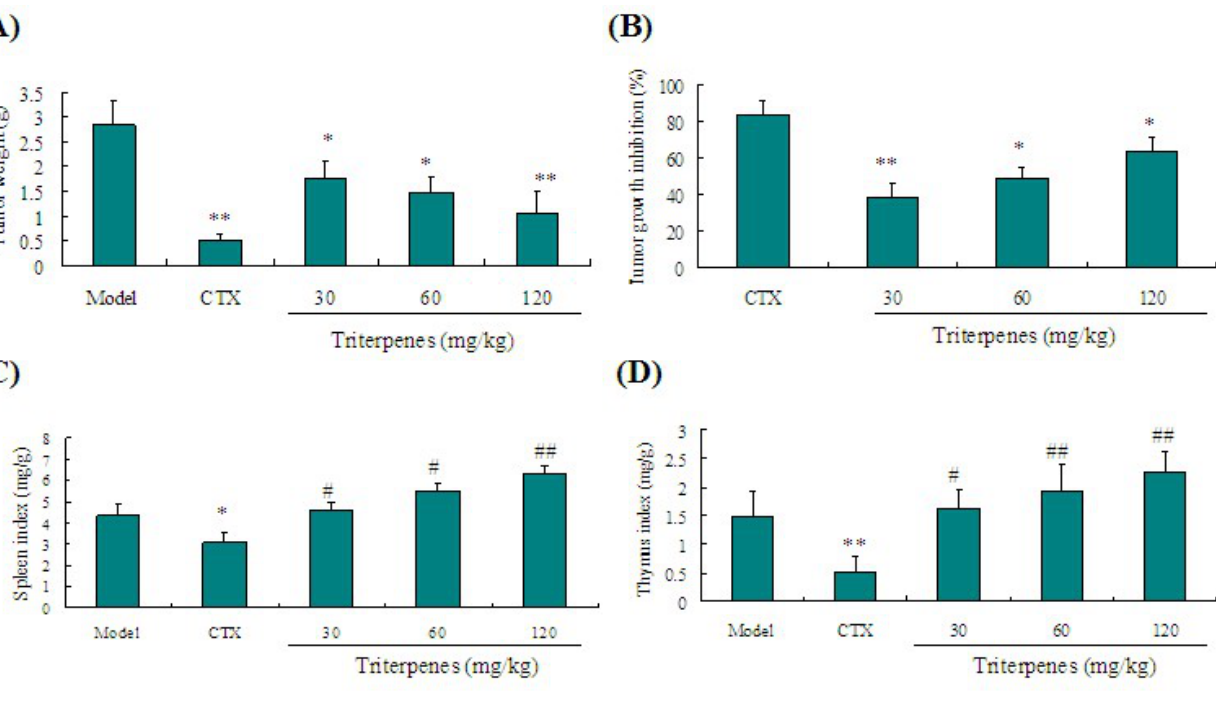
Figure 5. Effect of triterpenes of GLK on tumor growth and immune organ indexes in Lewis tumor-bearing mice. ( A ) tumor weight; ( B ) inhibition ratio of tumor growth; ( C ) spleen index; ( D ) thymus index. All data were taken from different individual experiments and expressed as means ± SD ( n = 8).